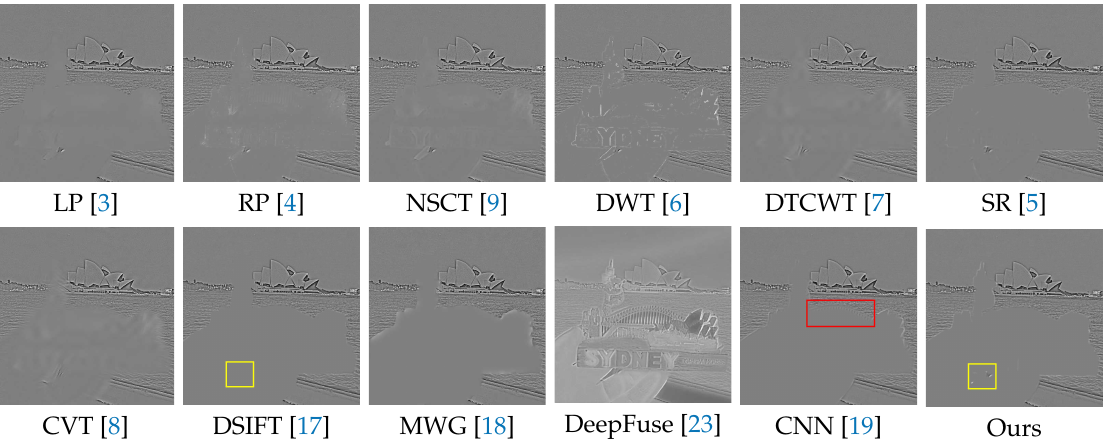
Figure 12. The difference images obtained by subtracting one source image from each fused image (see Figure